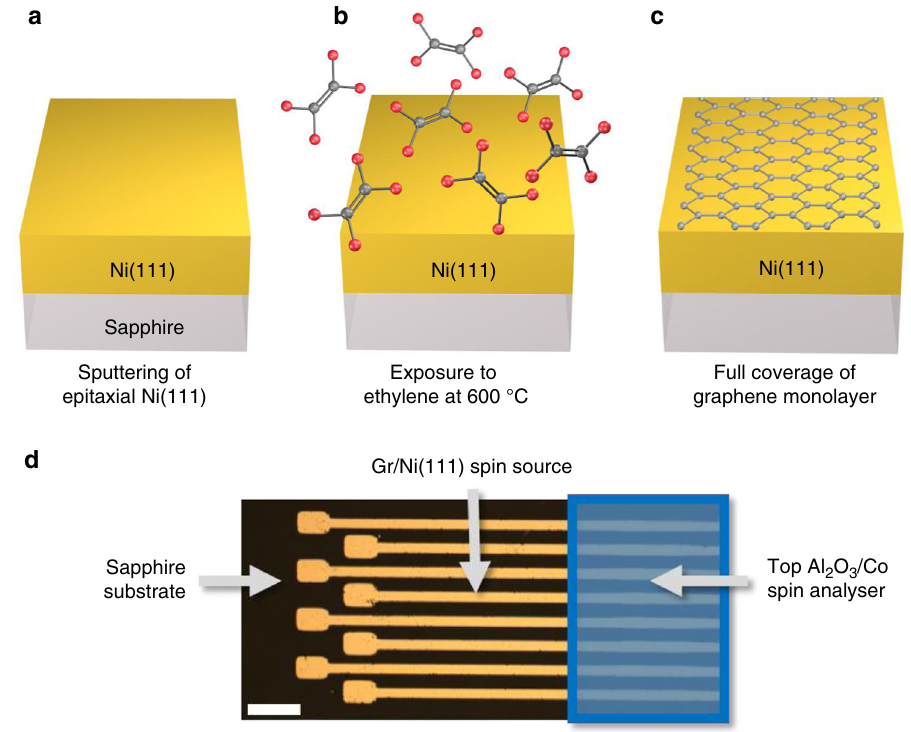
Fig. 1 Schematic illustration of the main steps for the Ni(111)/graphene spin source fabrication. a Ni(111) is epitaxially grown by a sputtering step at 600 °C on sapphire substrate. b The Ni(111) fi lm is then exposed to a low pressure 600 °C CVD step using ethylene as a carbon precursor. c This results in the full coverage of the Ni(111) electrode with an epitaxial graphene monolayer. d Optical image of the patterned Ni(111)/graphene spin source (scale bar corresponds to 200 µ m). A top Al 2 O 3 /Co spin analyzer is further deposited on patterned